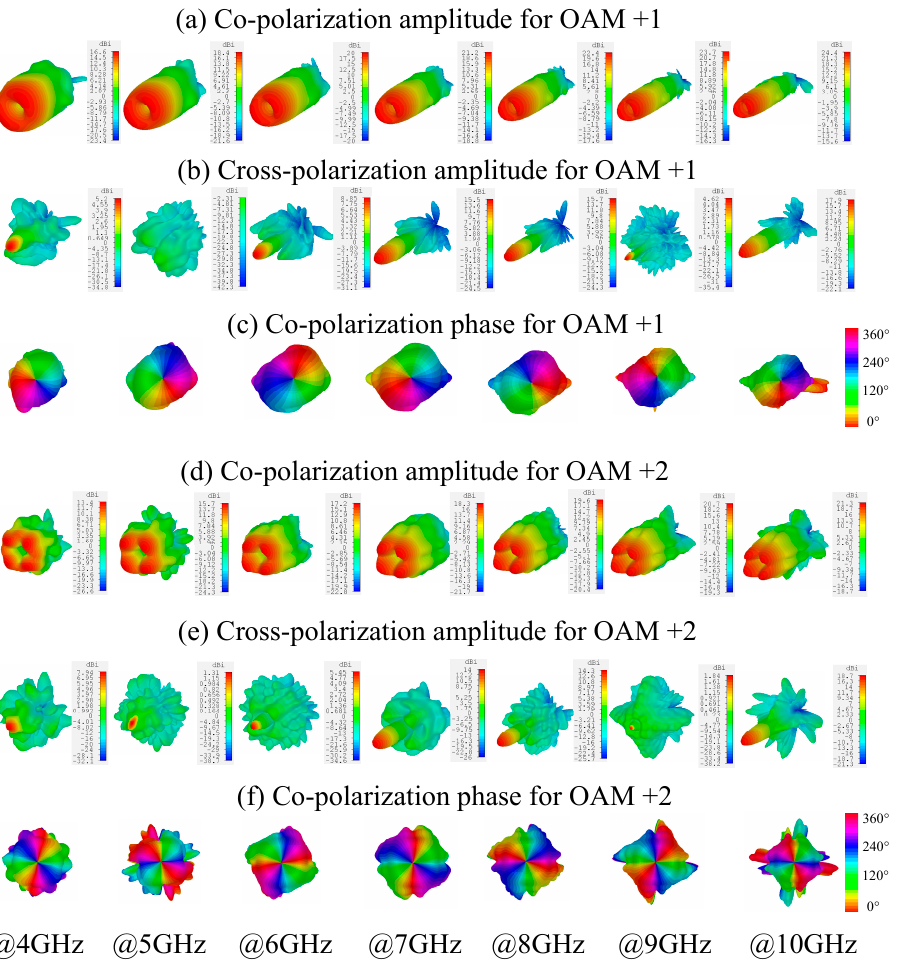
Figure 5. The simulated far-field pattern of the reflected beams: ( a ) Co-polarization and ( b ) Cross- polarization amplitude for OAM + 1. ( c ) Co-polarization phase for OAM + 1. ( d ) Co-polarization and ( e ) Cross-polarization amplitude for OAM + 2. ( f ) Co-polarization phase for OAM + 2.